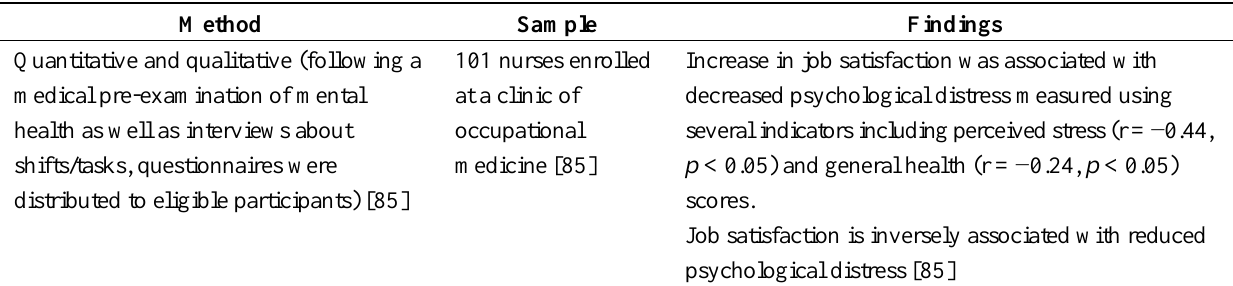
Table 10. Method, sample and findings of identified